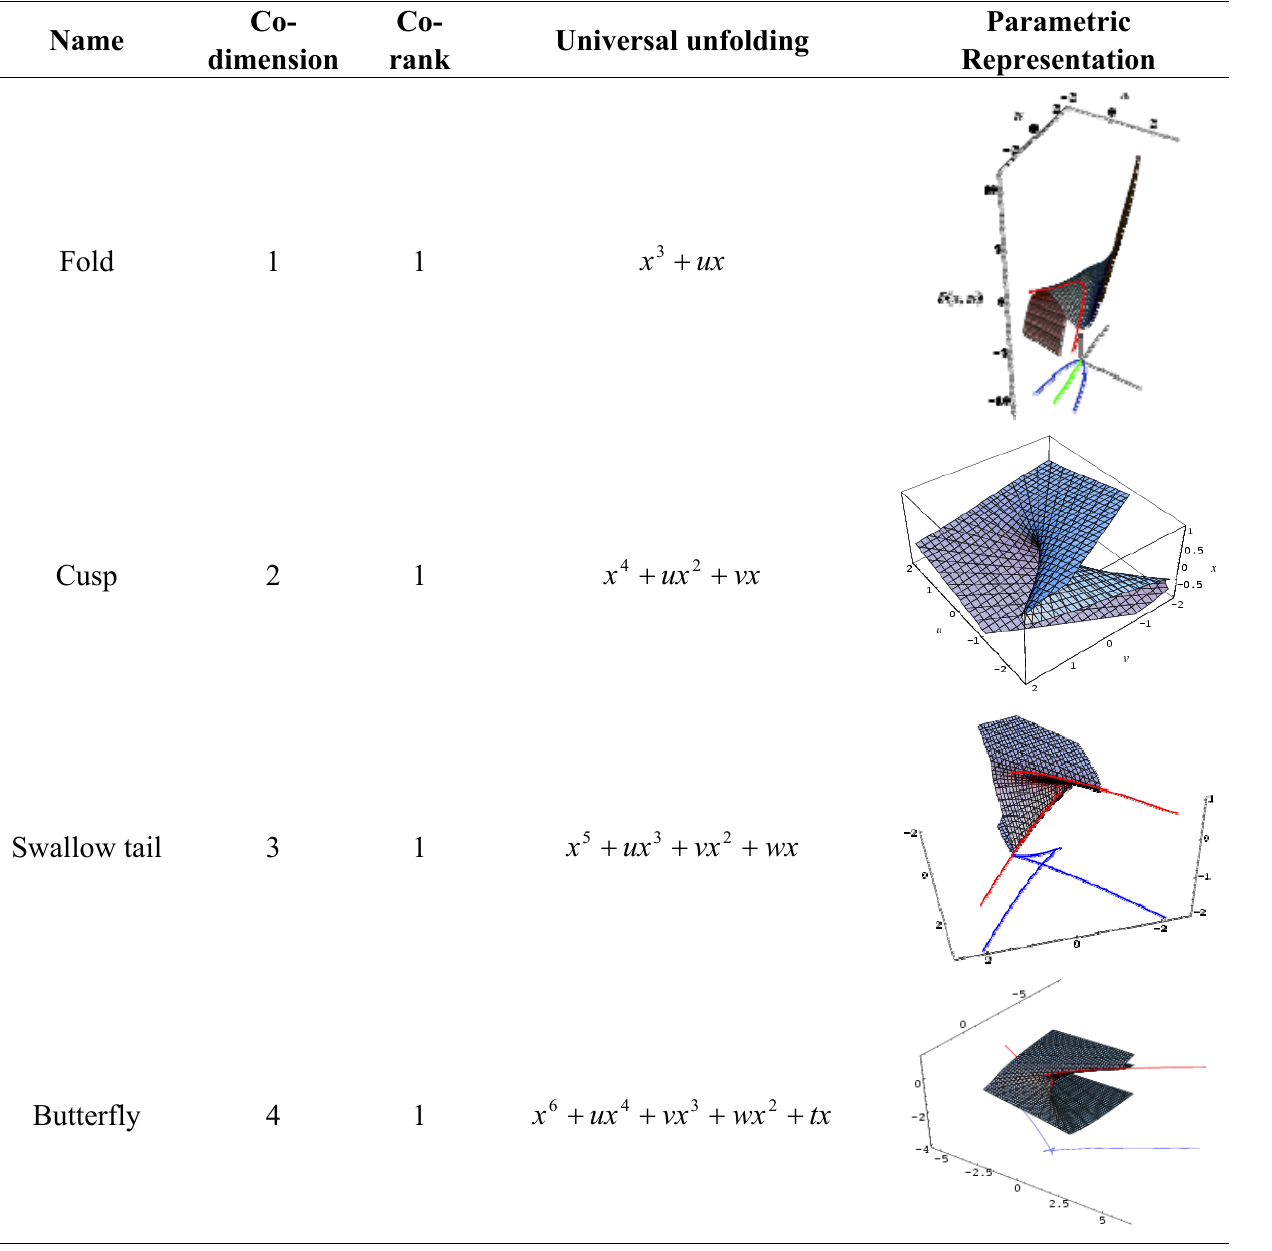
Table 2. Thom’s Classification of Elementary Catastrophes